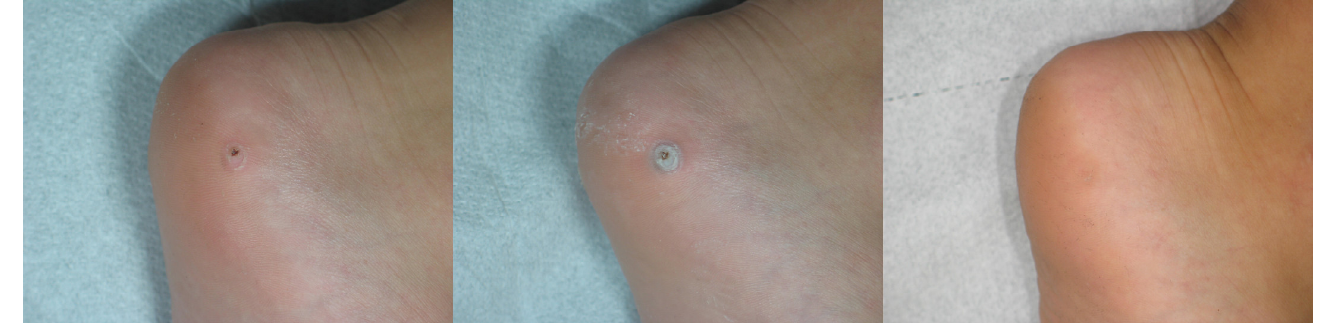
Figure 3. Patient n. 6 before treatment ( left ), immediately after combined treatment ( central ), and 4 months after treatment ( right ).